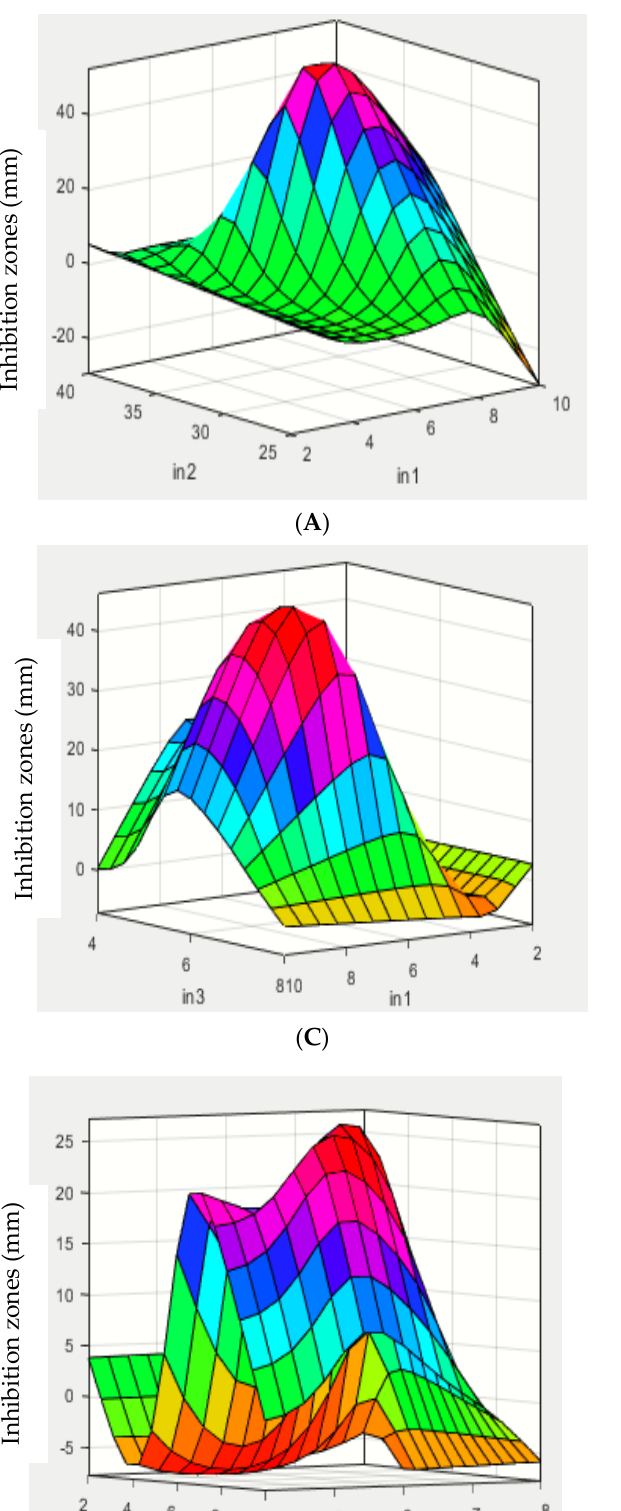
Figure 2. Coefficient (R 2 ) of training, testing, and validation data for antimicrobial production as determined by ANN analysis. ( A ) E. carotovora Erw 5 . ( B ) E. carotovora EMCC 1687.